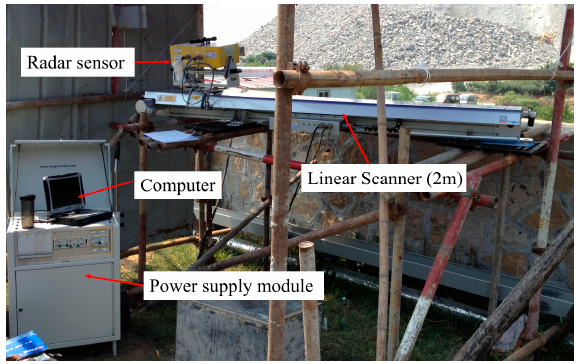
Figure5. IBIS-Lsystem(fromInnovativeInterferometricRadarforEnvironmentalandCivilEngineering Figure 5. IBIS-L system (from Innovative Interferometric Radar for Environmental and Civil Applications, Italy) composition. Engineering Applications, Italy) composition.